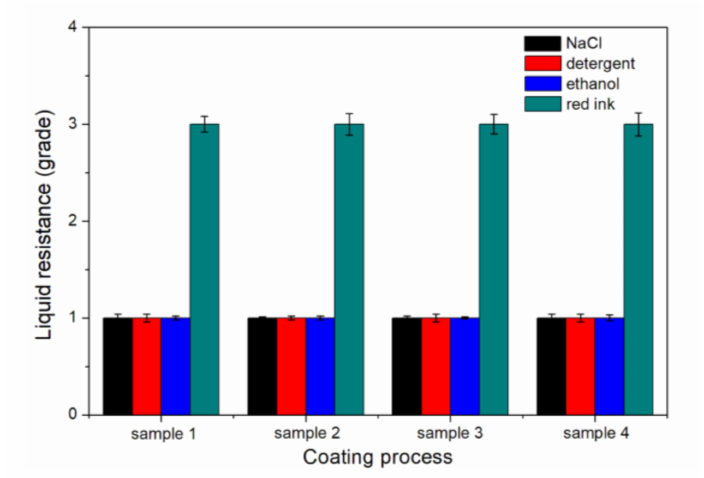
Figure 6. The liquid resistance of waterborne coating on Chinese fir (samples 1–4 from Table